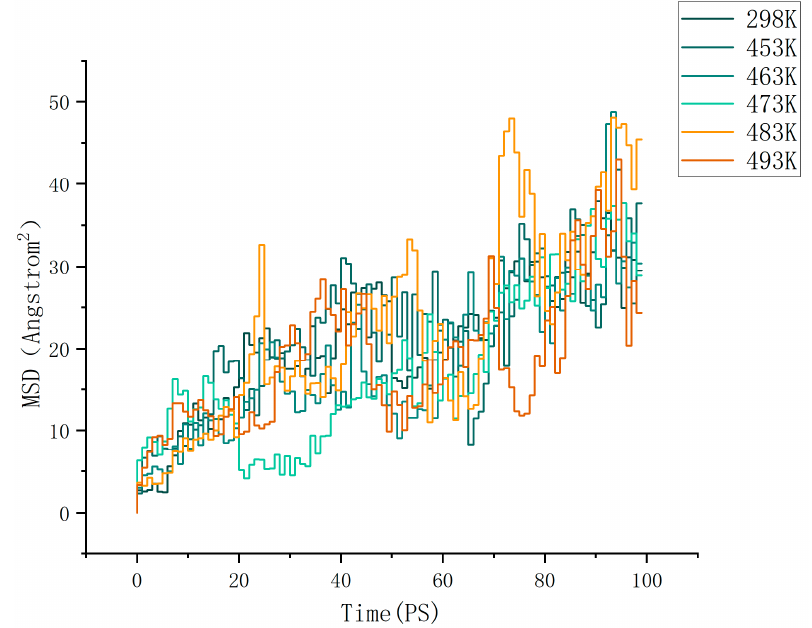
Figure 4. MSD of cellulose–formaldehyde model.